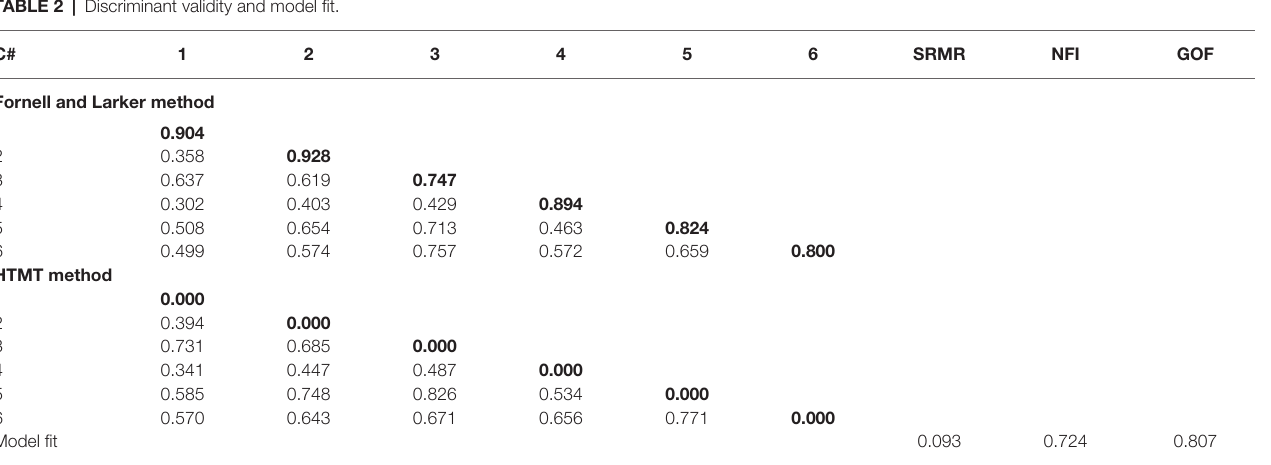
TABLE 2 | Discriminant validity and model